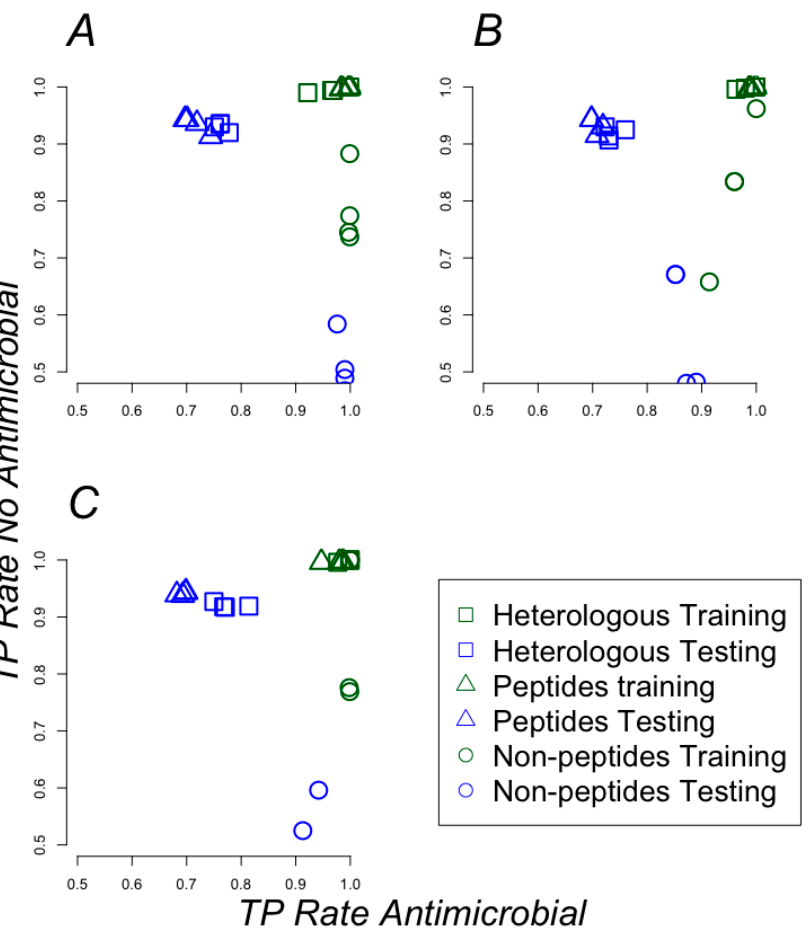
Figure 5. Learning efficiency based on physicochemical features. ( A ) Anti-infective, ( B ) anti-gut1, and ( C ) anti-gut4 training sets. True positive (TP) rates (number of correct predictions divided by the number of positive instances) for classifying antimicrobials and non-antimicrobials are shown for models trained with each training sets (green symbols) and for a 10-fold cross-validation test (blue symbols). Squared symbols correspond with models trained with heterologous data (peptides and non-peptide compounds); triangle symbols represent models trained with peptides; circular symbols represent models trained with non-peptidic compounds.